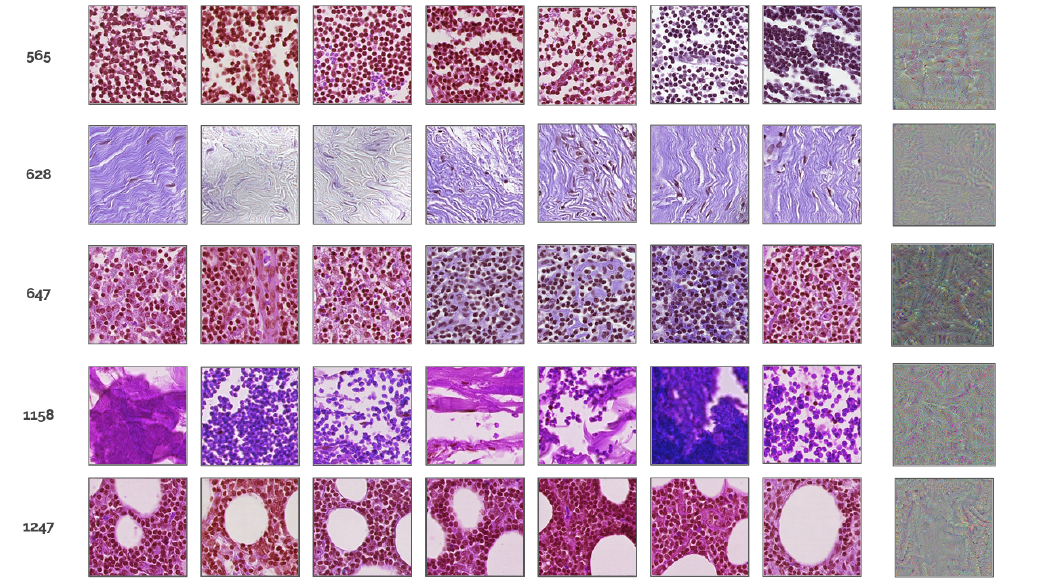
Figure A1. Features selected by CHOWDER model to describe “normal” class.